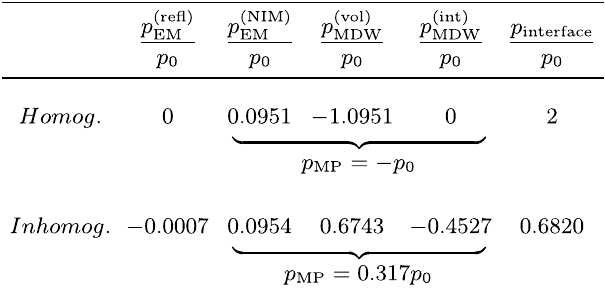
Table 1. Momentum components after the light pulse has entered the NIM. When the light pulse enters the NIM, the incident EM momentum component p 0 in the direction of propagation is split to partial momentum components carried by the reflected EM field ( p